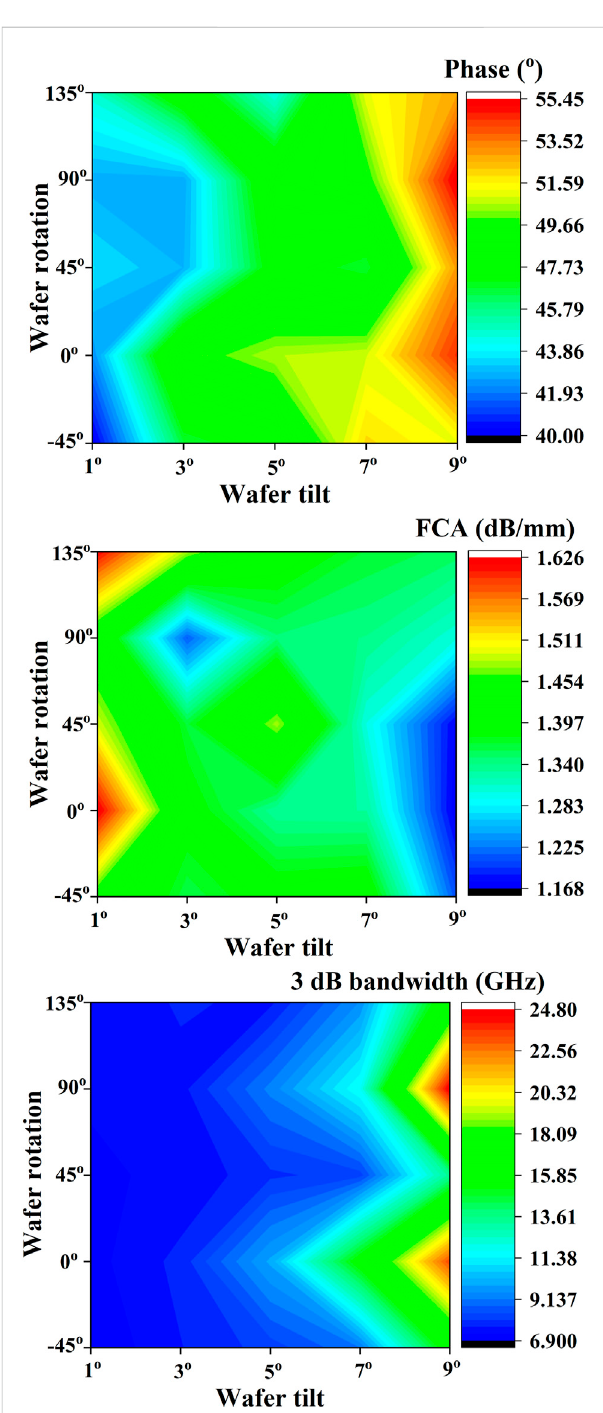
FIGURE 9 Image plot of (A) phase shift per unit length, (B) free-carrier absorption per unit length, and (C) 3-dB bandwidth at -5 V as a function of the wafer rotation and wafer tilt B respectively. The effect of different annealing temperature and time on the phase shift is negligible. However, compared to the reference phase shifter, lower temperature, longer duration annealing leads to 1.12× lower absorption loss. The phase shifter